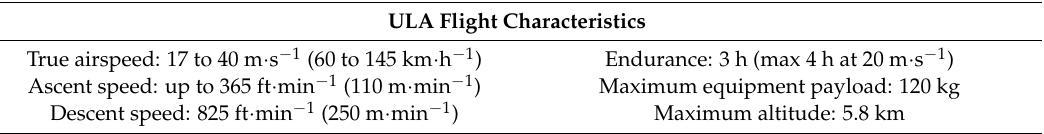
Figure 2. Tanarg 912 S BioniX 15 ultra-light aircraft (ULA). The airborne Lidar for atmospheric surveys using Raman Scattering (LAASURS) is embedded on the left side of the ULA. Table 2. Tanarg 912 XS ultra-light aircraft (ULA) main flight characteristics.